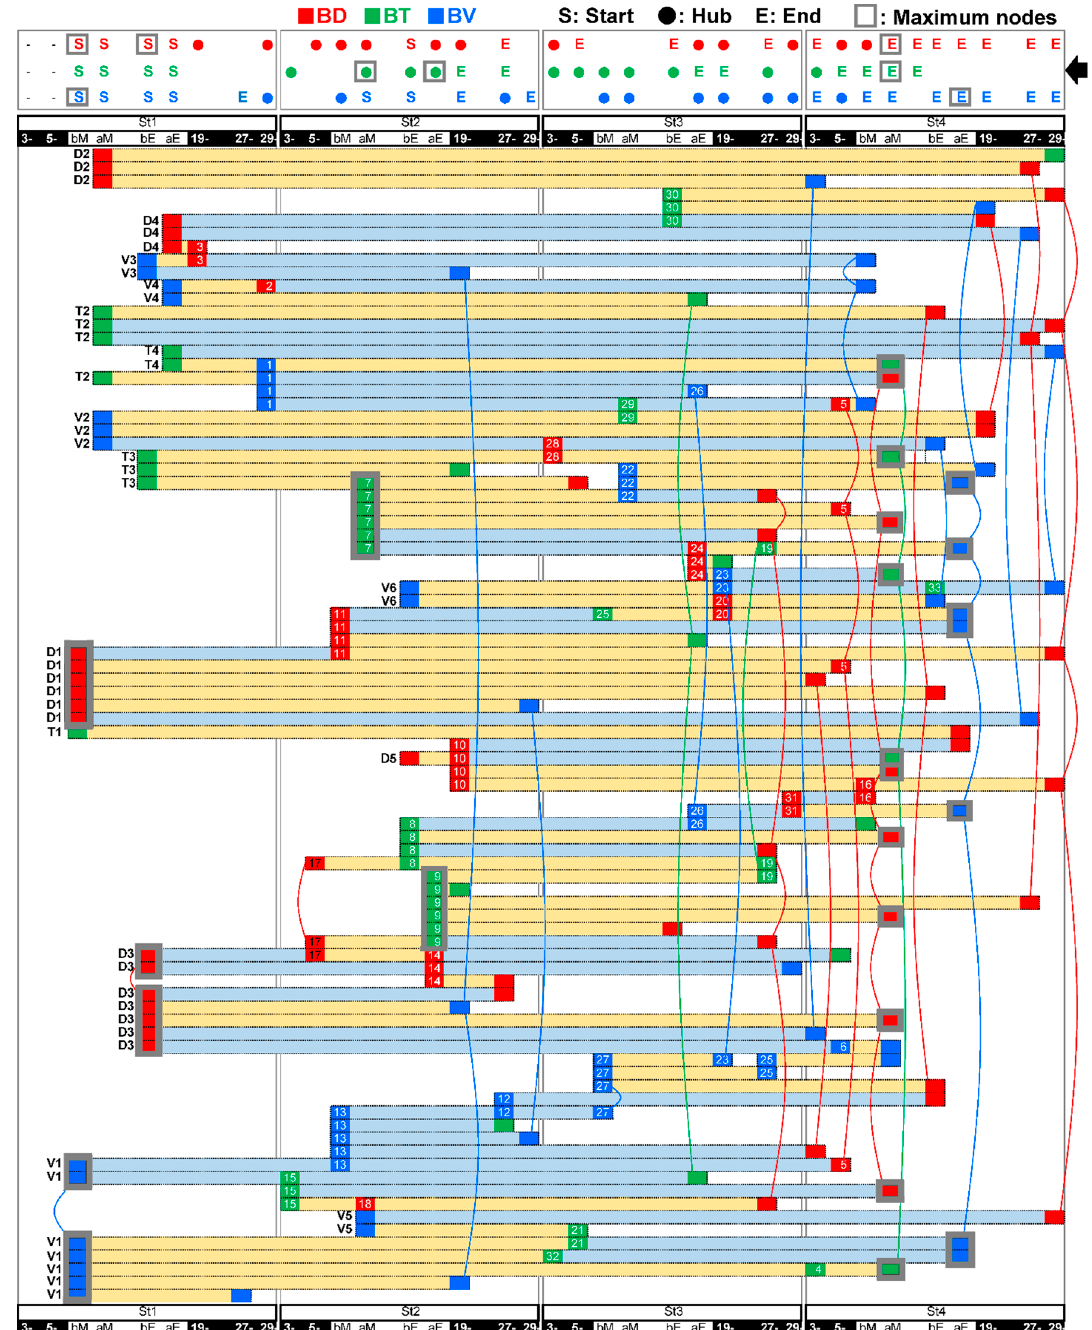
Figure 9. Connections of the feeding-dependent pathways depicted in Figure 8. The horizontal bars are the same as in Figure 8 re-arranged. The top table shows any presence of significant start (explanatory, “S”), hub-like relays (both explanatory and response, filled circle), or end (response, “E”) variables. Gray squares indicate the maximum response node (MRN) or maximum explanatory node (MEN) in each variable (see also Figures 10 and 11). Same variables separately arranged are connected with one another with colored curves. The start points at St1 or St2 are marked by V1–V6, D1–D5 and T1–T4.